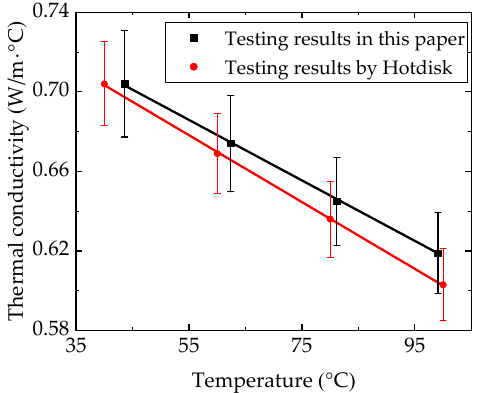
Figure 13. Thermal conductivities of erythritol at di ff erent temperatures.